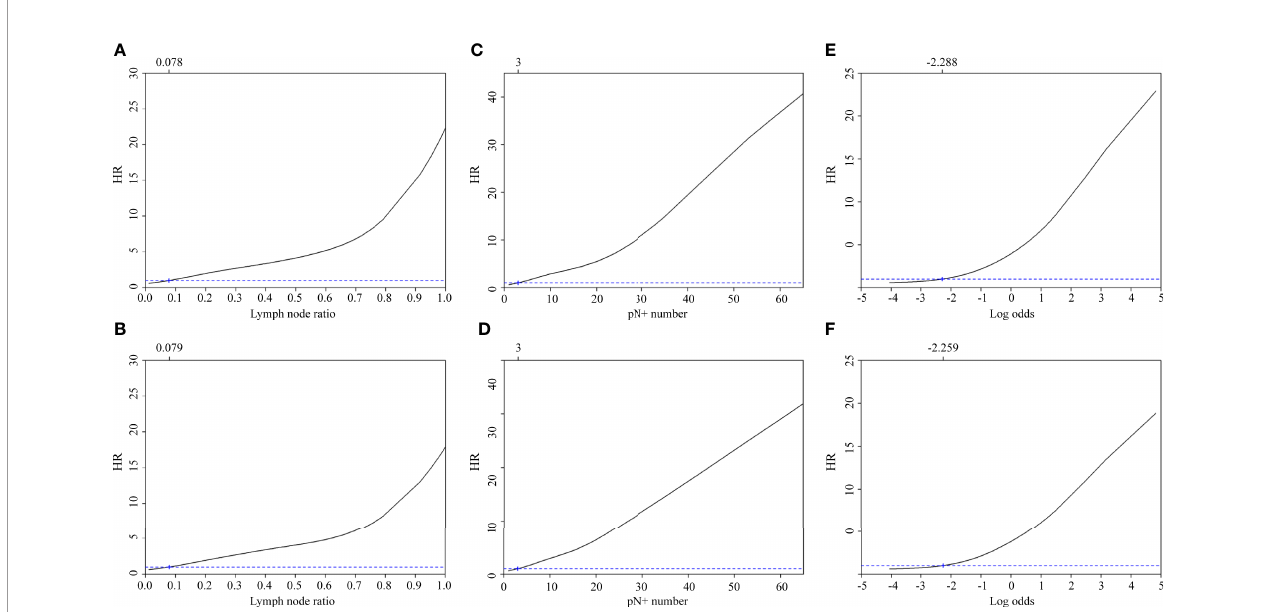
FIGURE 2 | Adjusted hazard ratios for 5-year disease-speci fi c survival and overall survival according to the lymph node ratio (A, B) , the number of pathologically positive nodes (C, D) , and the log odds of positive lymph nodes (E, F)